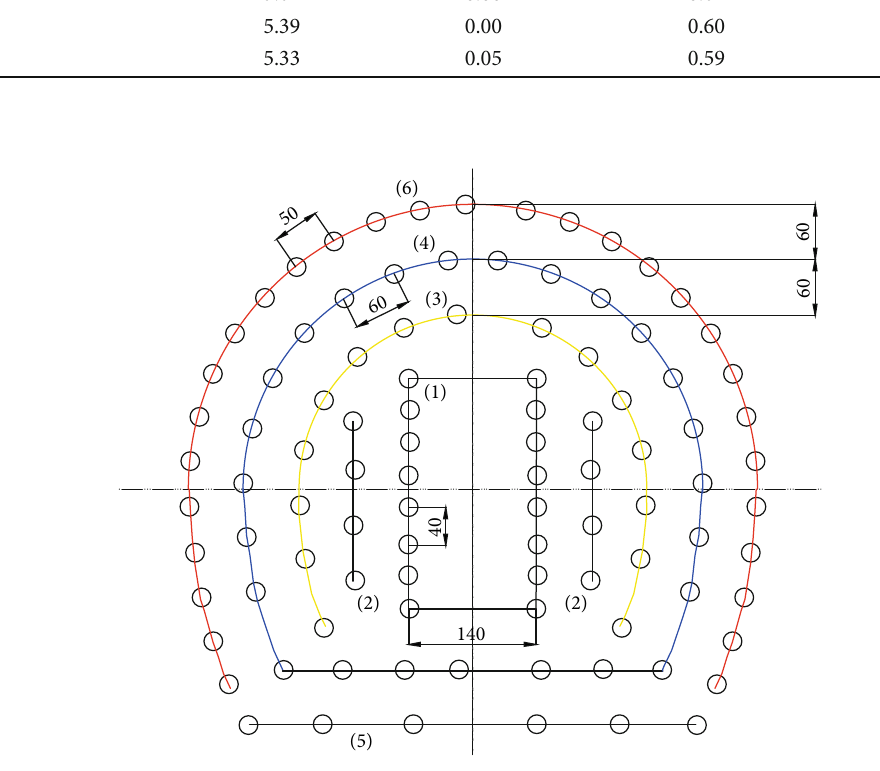
Figure 11: Layout of the adjusted smooth blasting